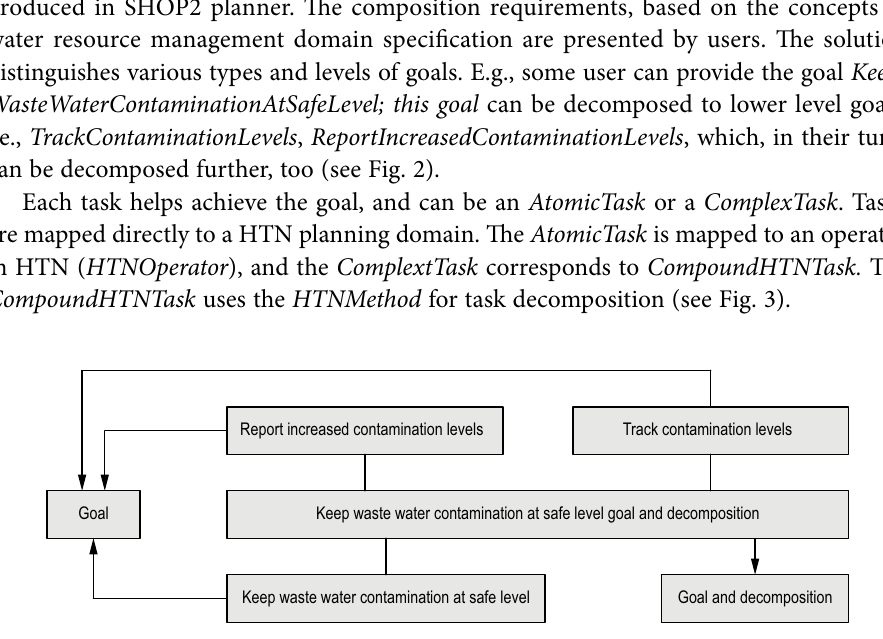
Keep waste water contamination at safe level Goal Fig. 2. An example of goal decomposition